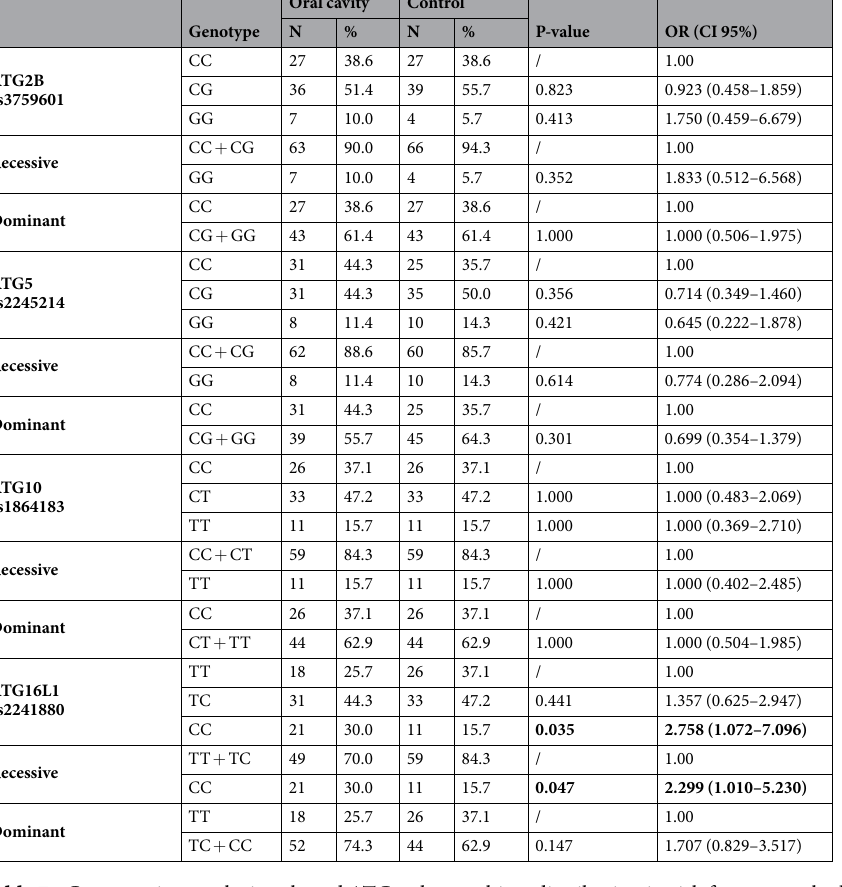
Table 7. Comparative results in selected ATG polymorphism distribution in risk factor-matched oral cavity cancer and controls. Statistically significant results in